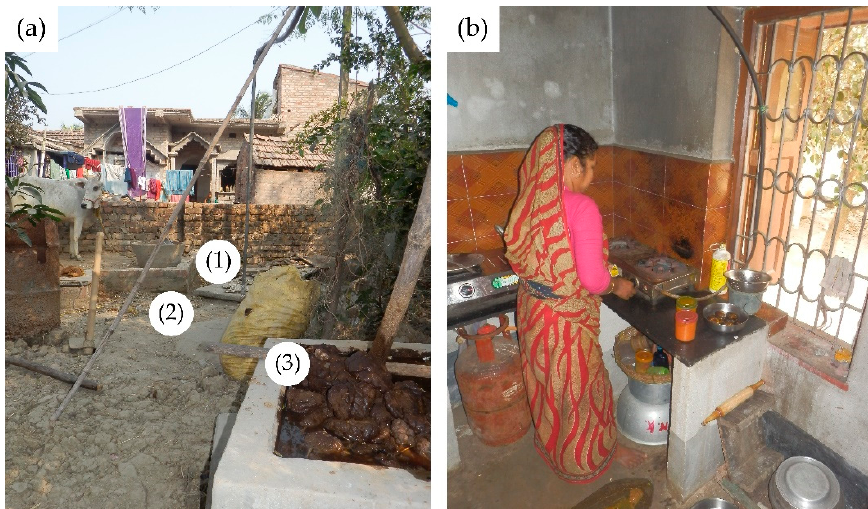
Figure 7. Household biodigester ( a ) Deenbandhu Model: (1) inlet filled with manure and water; (2) underground fixed-dome fermenter, and (3) outlet chamber in the rural village of Ghoragachha, West Bengal India. ( b ). Women cooking on a biogas stove, directly connected with the